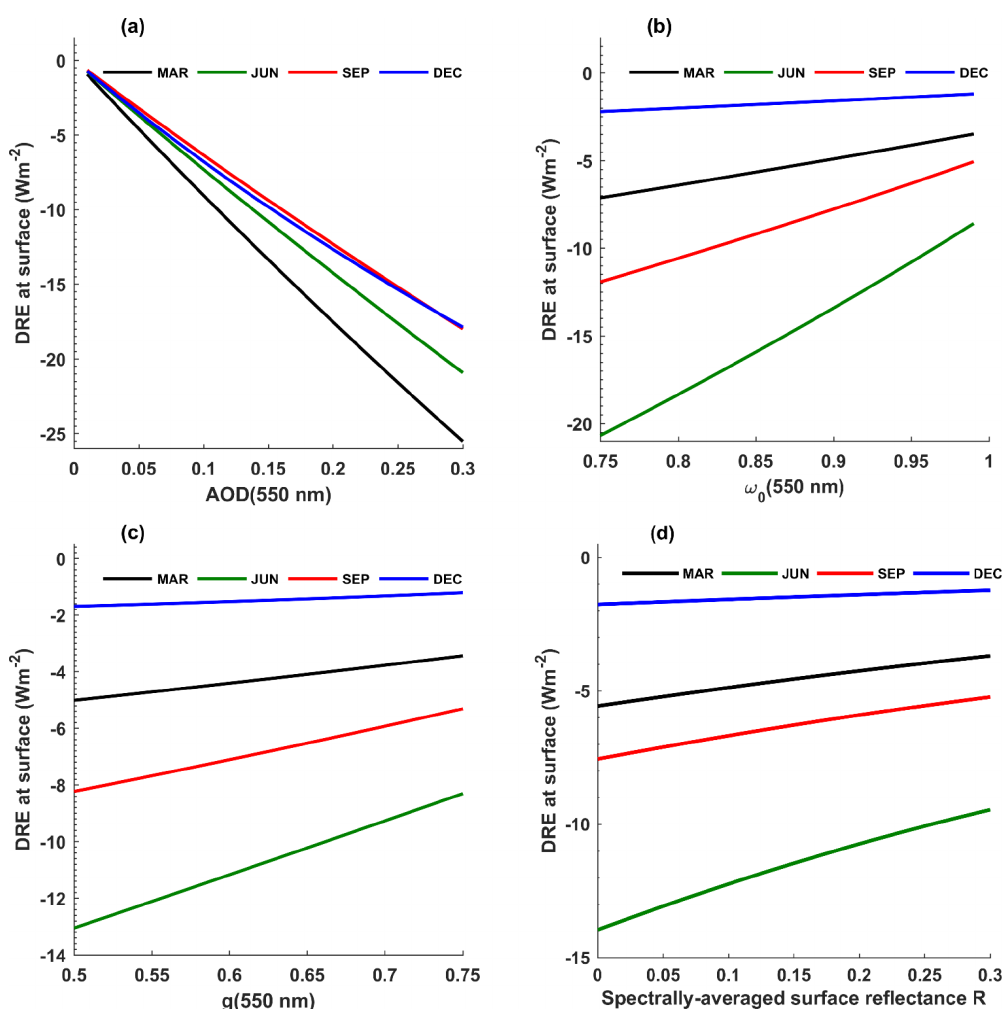
Figure 7. Seasonal dependence of the sensitivity of aerosol DRE at the surface to (a) AOD; (b) ω 0 ; (c) g ; and (d) spectrally-averaged surface reflectance R